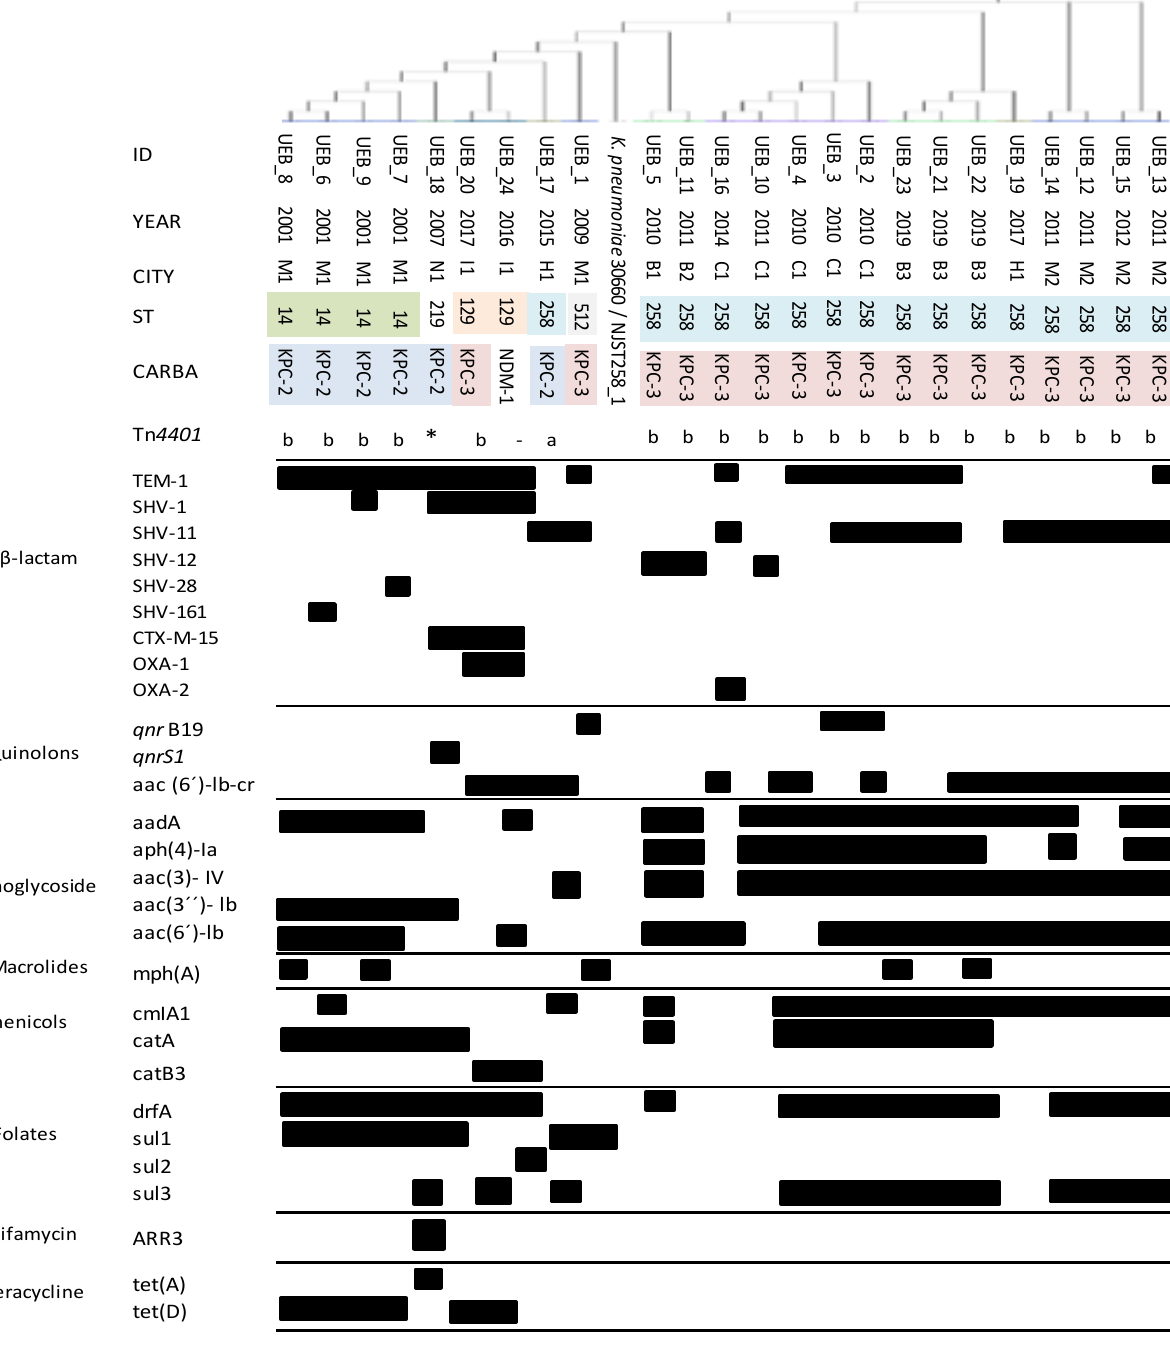
Figure 1. Genomic characteristics of the 24 K. pneumoniae isolates included in this study. C1: Cali, M1: institution 1 Medellin, M2: institution 2 Medellin, B1: Institution 1 Bogotá, B2: institution 2 Bogotá, B3: institution 3 Bogotá, N1: Neiva, I1: Ibague, H1: Pasto. Black indicates presence, * not- Tn4401.